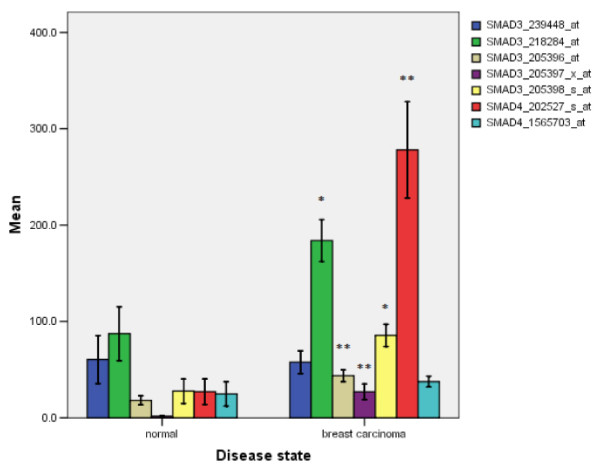
SMAD3 and SMAD4 expression in breast carcinoma relative to normal tissue. Expression data were obtained from Affymetric GeneChip U133 Plus 2.0 arrays for 50 tumors and 10 surrounding unaffected tissues. Statistical significance was determined by two independent sample t-tests and Levin's tests for the equality of variance.